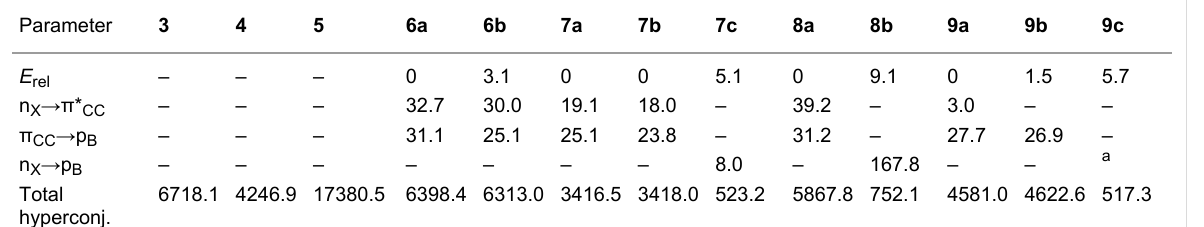
Table 5: Conformational energies (in kcal mol − 1 ) and hyperconjugative interactions (in kcal mol − 1 ). Parameter